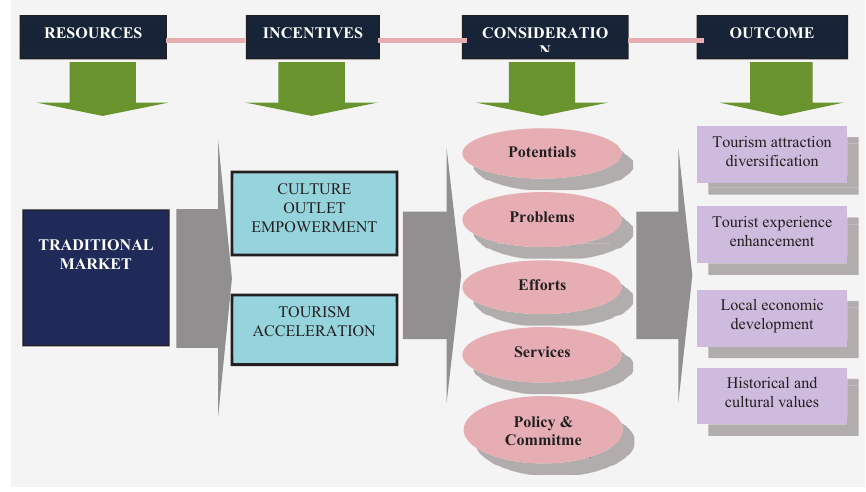
Figure 4. Cultural Outlet and Tourism Acceleration Model